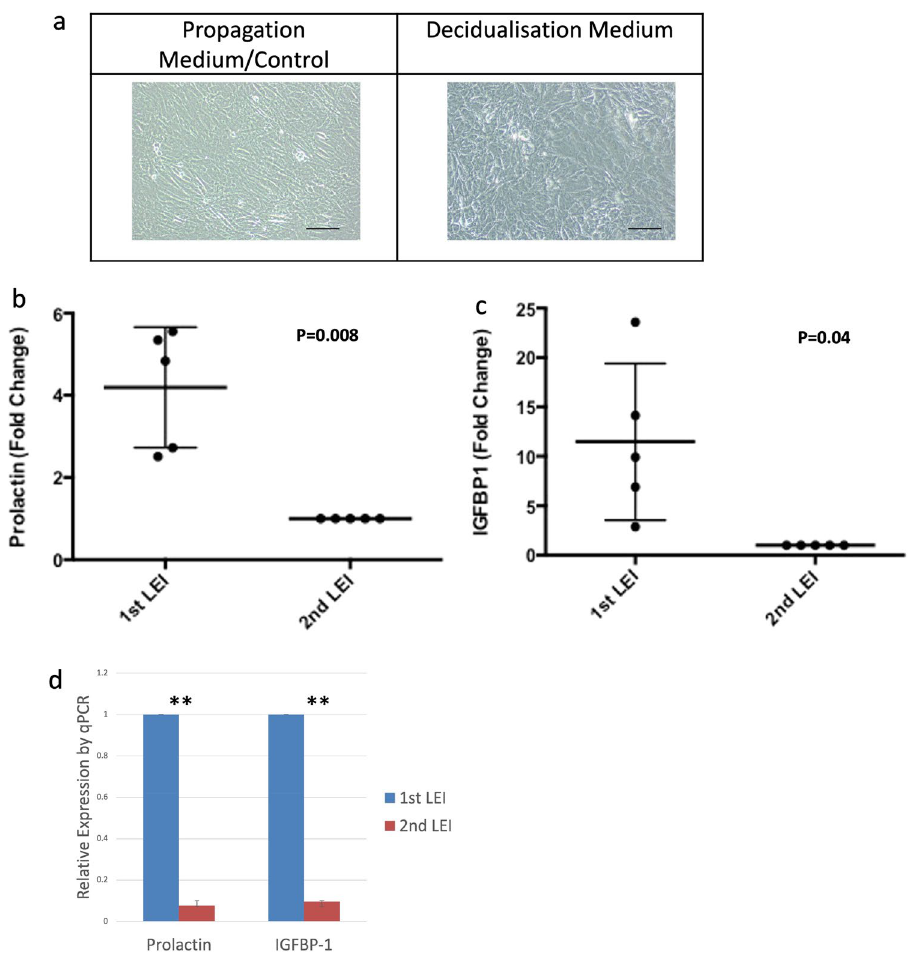
Figure 5. Altered decidualization capacity of SUSD2 + cells between first and second LEI. Confluent SUSD2 + cells adopt an epitheloid shape with prominent nucleoli and denser cytoplasm in the presence of MPA and 8-bromo-cAMP ( a ). Scale bar 100um. All 5 samples showed a reduction in Prolactin ( b ) and IGFBP1 ( c ) protein levels in the supernatant between first and second LEI. Relative expression of both PRL (Prolactin) and IGFBP1 mRNA by qPCR also showed marked reduction between ( d ). Data normalized to Prolactin and IGFBP1 levels of cells cultured in propagation medium. ** p <